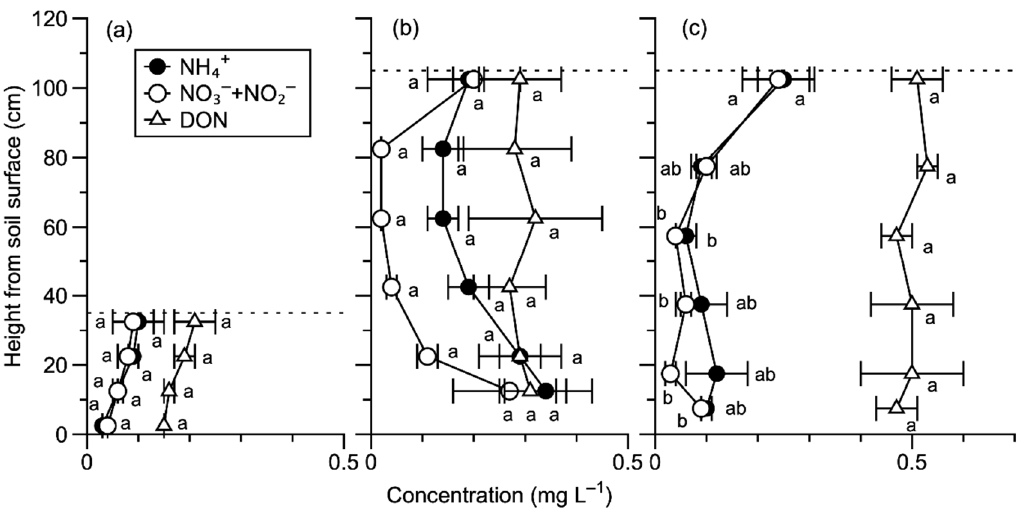
Figure 4. Average concentration (mg L –1 ) of dissolved nitrogen at each snowpack depth in January 2016 ( a ), January 2017 ( b ), and March 2018 ( c ). Error bars show standard error ( n = 3). DON = Dissolved organic nitrogen. Dashed lines show snow depth. Different letters indicate significant differences of dissolved nitrogen concentration among snow depths at p < 0.05.